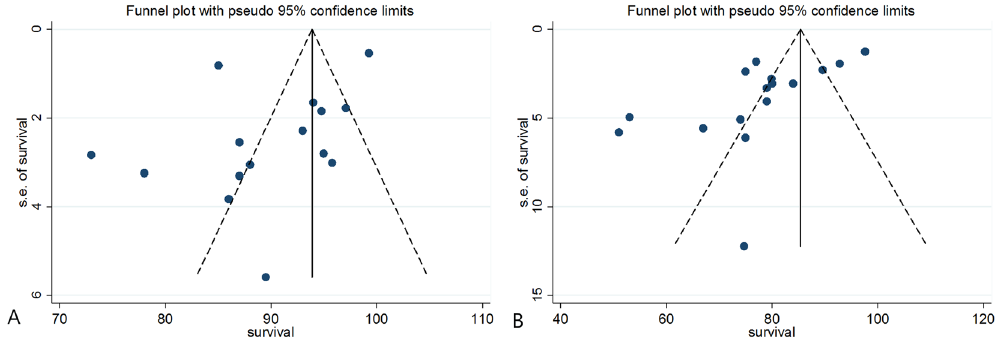
Figure 2. Funnel plot showing relatively symmetrical data on ( A ) 5-year survivalship of closed wedge high tibial osteotomy (HTO) and asymmetricity on ( B ) 10-year survivalship of closed wedge